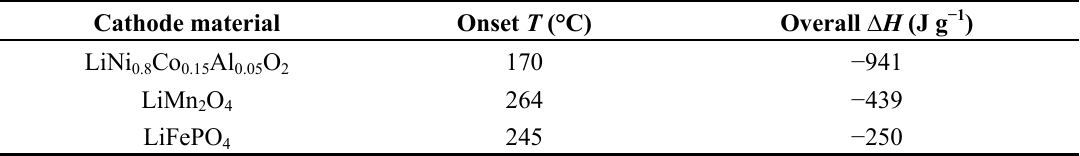
Table 2. Flow of enthalpy deduced from the DSC spectra of the fully delithiated and over charged carbon-coated LiFePO and the fully lithiated carbon-coated graphite that of the 4 overcharged cathode elements investigated are reported in the three last